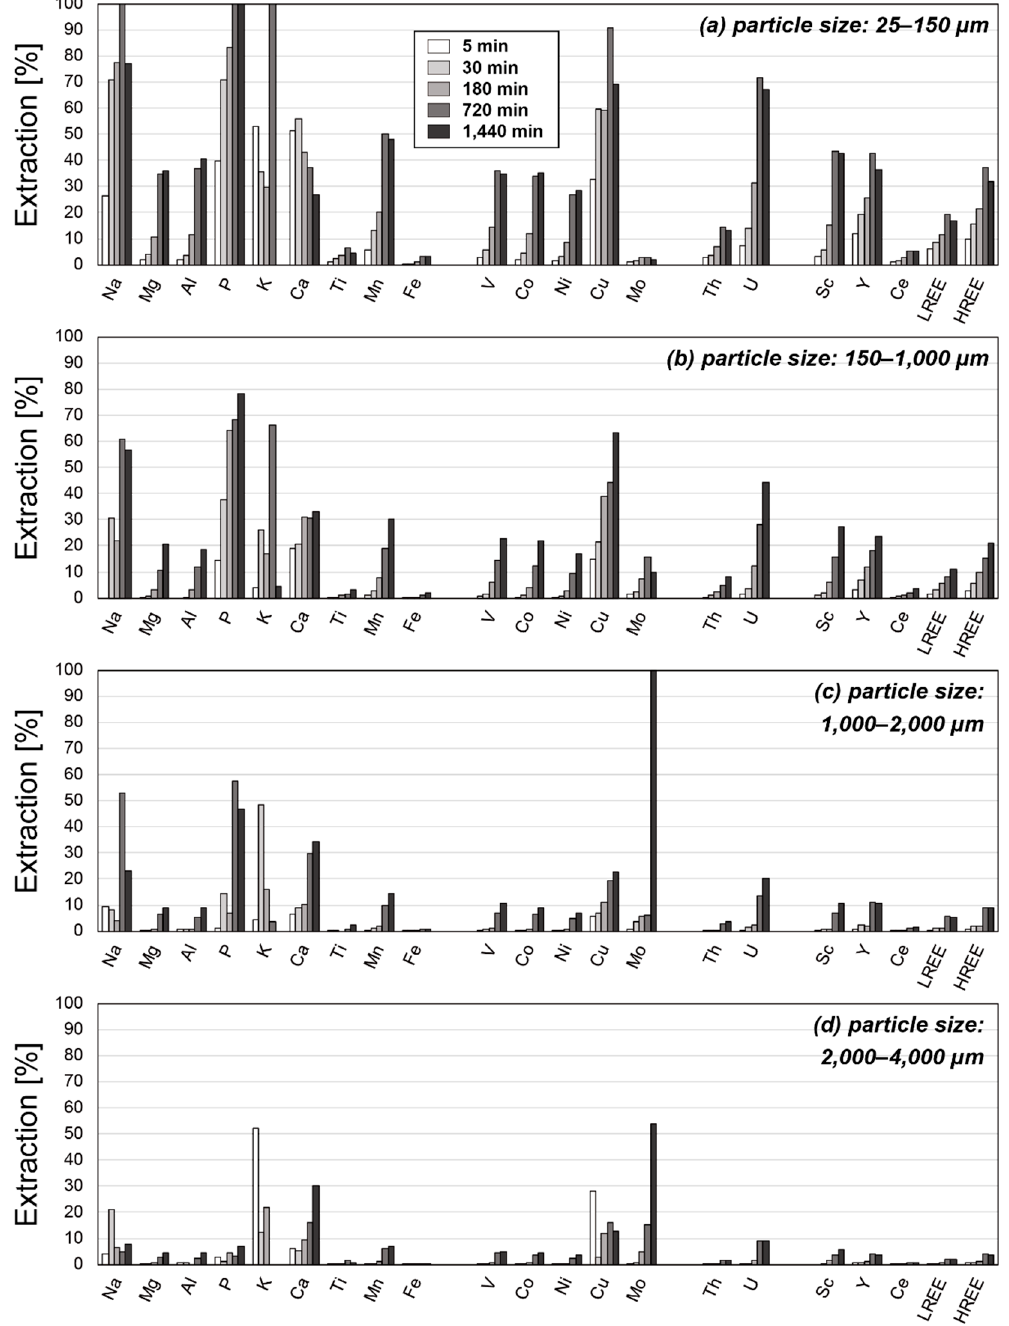
Figure 4. Extraction percentages of major elements, valuable metals, radioactive elements, and REE from the Kunimiyama umber as a function of time using sulfuric acid as a leachate. Experiments with the particle size of ( a ) 25–150 μ m, ( b ) 150–1000 μ m, ( c ) 1000–2000 μ m, and ( d ) 2000–4000 μ m.